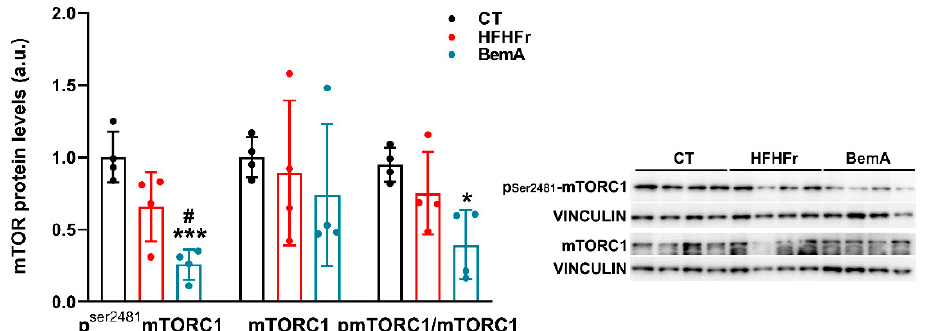
Figure 8. Effect of Bempedoic acid on mTORC1 protein levels in liver samples. Bar plots show liver phosphor-Ser 2481 mTORC1, total mTORC1 protein levels, and the ratio of phosphor to total mTORC1 protein levels from control (CT), high-fat high-fructose (HFHFr), and bempedoic acid (BemA)-treated rats. The results are expressed as the mean ± SD of four pooled samples, obtained by mixing equal amounts of tissue from two rats, for each condition. On the right side of the figure, representative western blot bands corresponding to the three different study groups are shown. a.u.: arbitrary units. Data were analyzed by one-way ANOVA followed by Tukey’s post-hoc test. * p < 0.05, *** p < 0.001 vs. CT; # p < 0.05 vs. HFHFr.